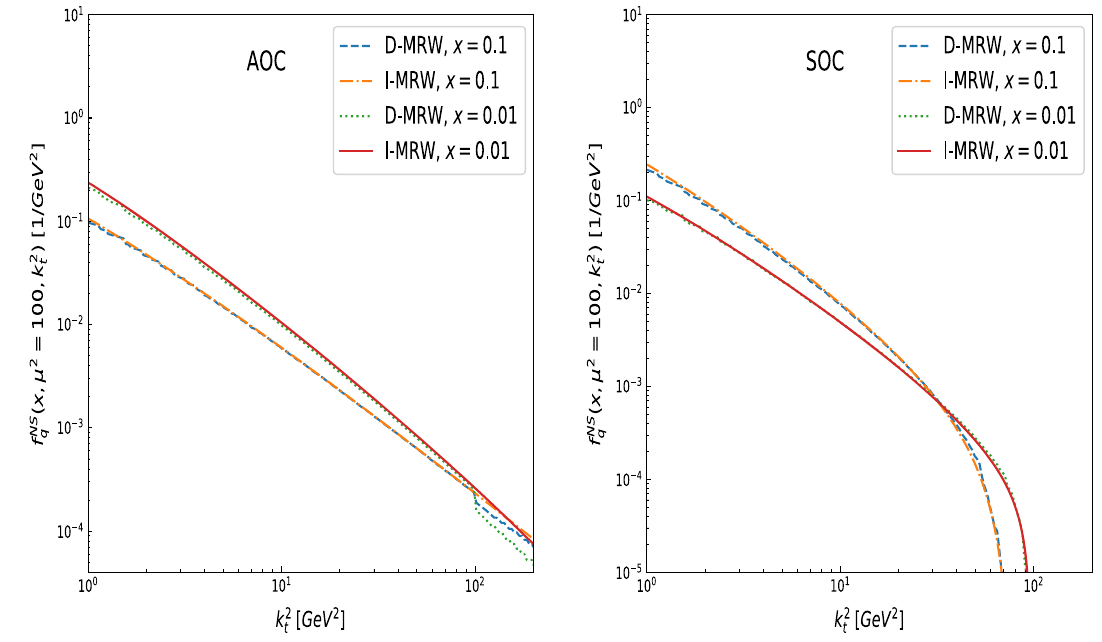
Fig. 4 The left (right) panel of the figure shows the numerical result of the Eq. (10) with the AOC (SOC) cutoff-dependent PDF. The differential (integral) UPDF of the Eq. (10) is denoted by D-MRW